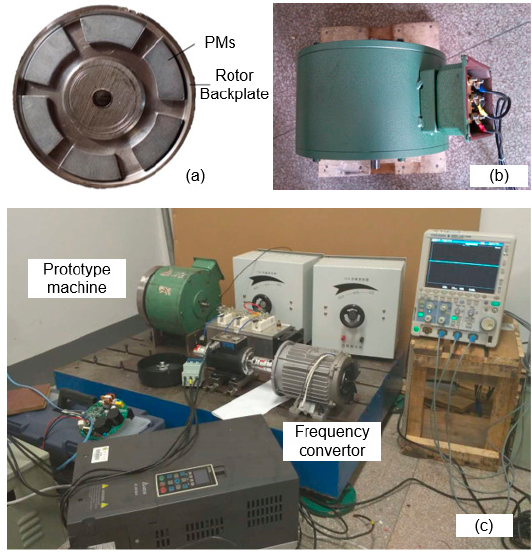
Figure 22. Experimental test rig. ( a ) The permanent magnet rotor; ( b ) The prototype machine; and ( c ) The test rig.